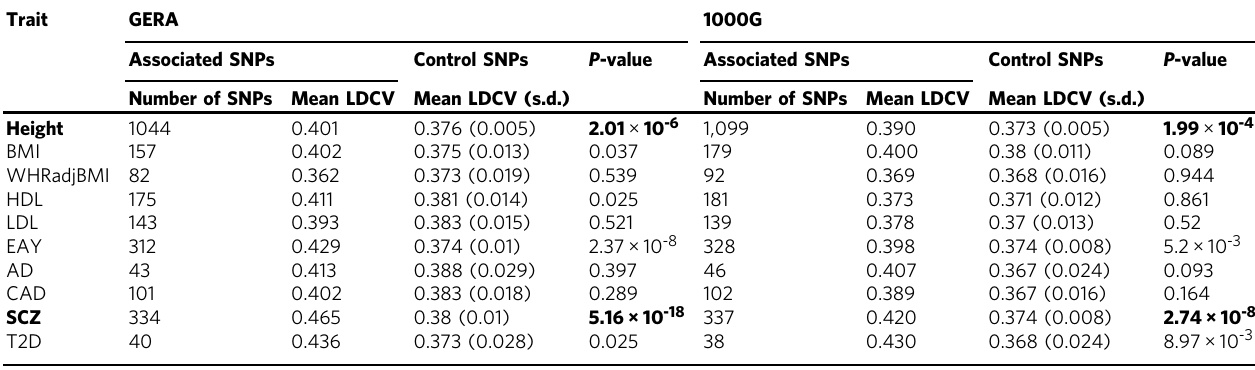
Table 2 Enrichment test of the differentiation of trait-associated SNPs (clumped at P < 5 × 10 − 6 ) in the LD pattern against the control SNPs among the three populations in GERA and 1000G Trait